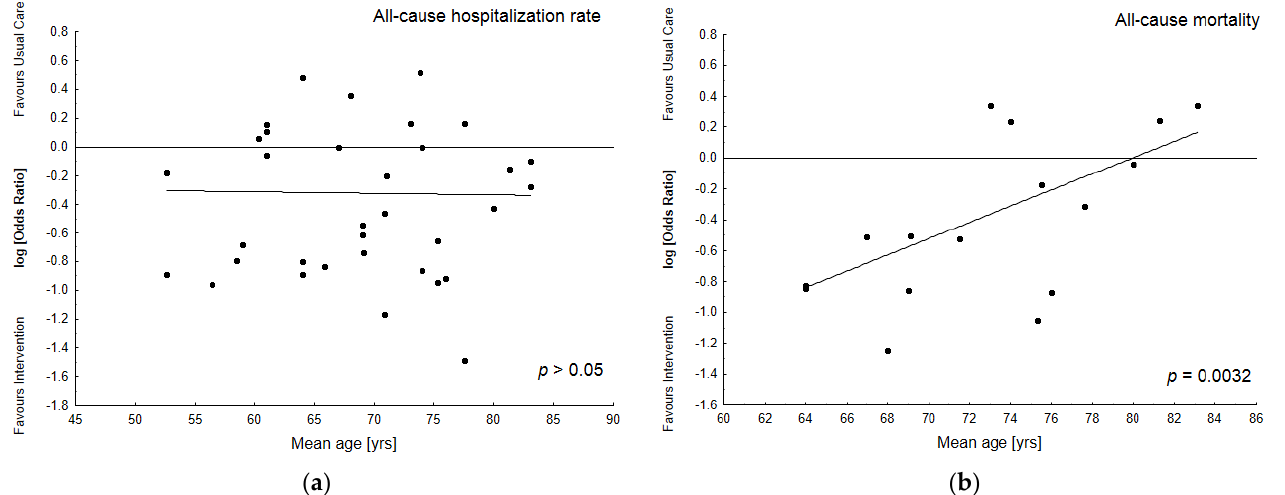
Figure 5. Bubble plots with fitted meta-regression lines of effect size demonstrate alterations in odds ratio (OR) for the particular outcome as a function of the mean age of subjects in the Intervention Group. ( a )—all cause hospitalization (NS); ( b )—all cause mortality ( p = 0.0032) [3,18,19,22,24–26,33,34,37,39–41,43–45,47].